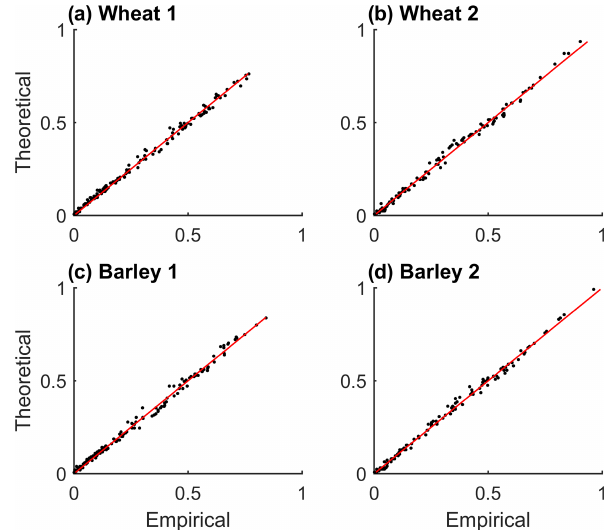
. Figure 4. Empirical versus theoretical probability distributions MAM based on the nested Frank copula models. (a) Wheat in Region 1. (b) Wheat in Region 2. (c) Barley in Region 1. (d) Barley in Re- gion